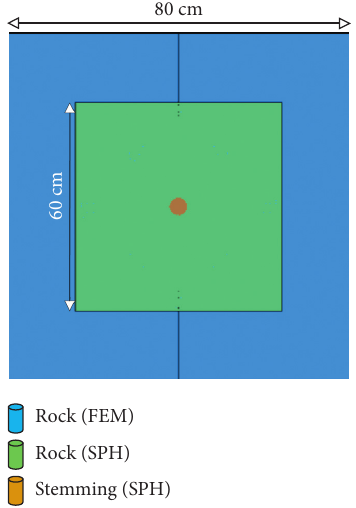
Figure 12: The 3D calculation model.